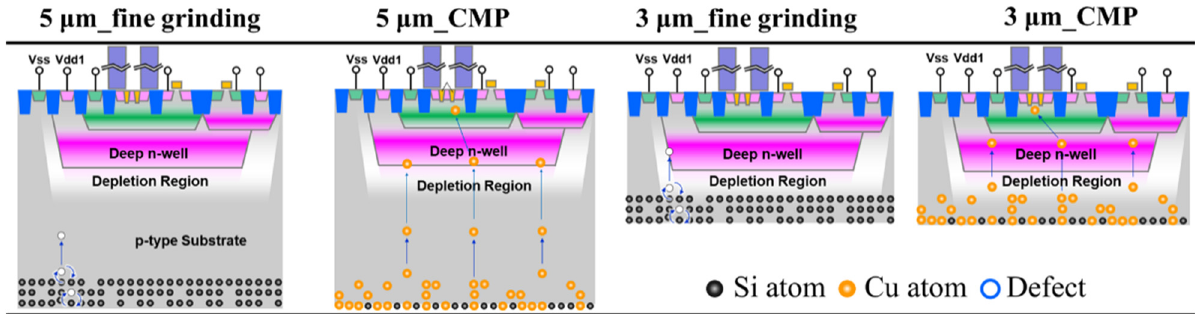
Figure 4. Schematic diagram of cross-sectional image of transistor and the degradation model for DRAMs after thinning. The depth of a deep N-well is about 2.0–3.0 μ m. The depth of the depletion region between the deep N-well and the substrate is calculated to be 3.0–4.0 μ m. In the case of a Si thickness of 5.0 μ m, the defects do not reach the depletion region, and thus both the standby current and retention characteristics do not change. When the Si thickness is being reduced to 3 μ m by fine grinding, the defects reach the depletion region. These defects in the depletion region increase the junction leakage current between the substrate (Vss) and the deep N-well (Vdd1). This causes an increase in standby current. On the other hand, since CMP treatment removes the grinding-induced defects and reduces diffused-defects at the depletion region, the standby current is improved.